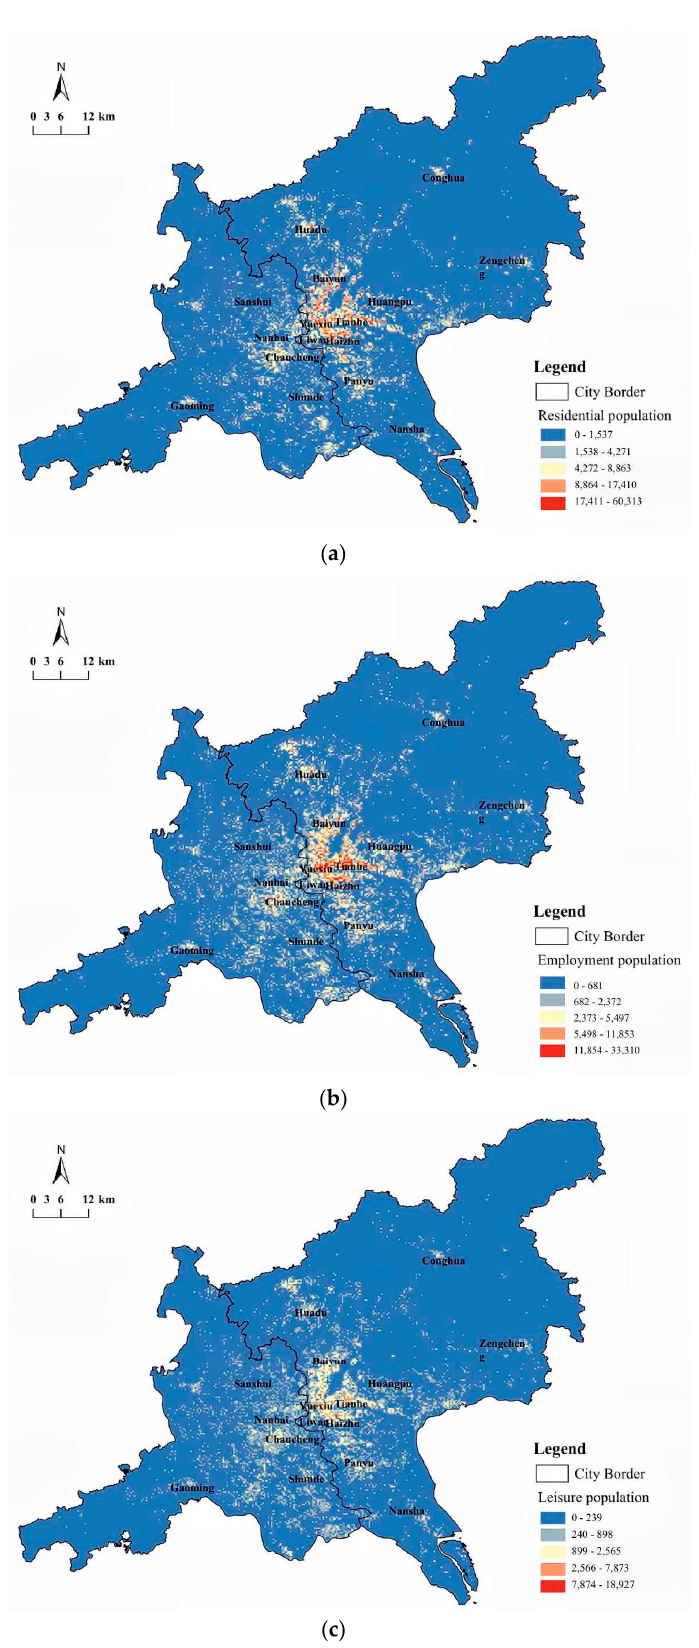
Figure 5. Population distribution of Guangzhou-Foshan in 2019. ( a ) Residential population distribution; ( b ) Employment population distribution; ( c ) Leisure population distribution.